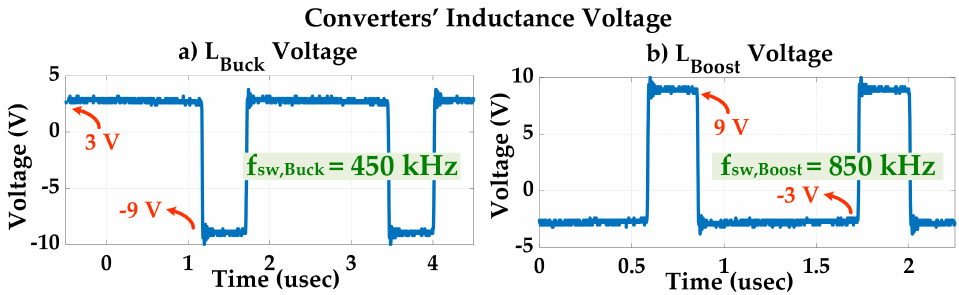
Figure 8. Buck and Boost’s inductance voltages (i.e., L buck and L Boost voltages) under continuous function, for a 12 V battery voltage